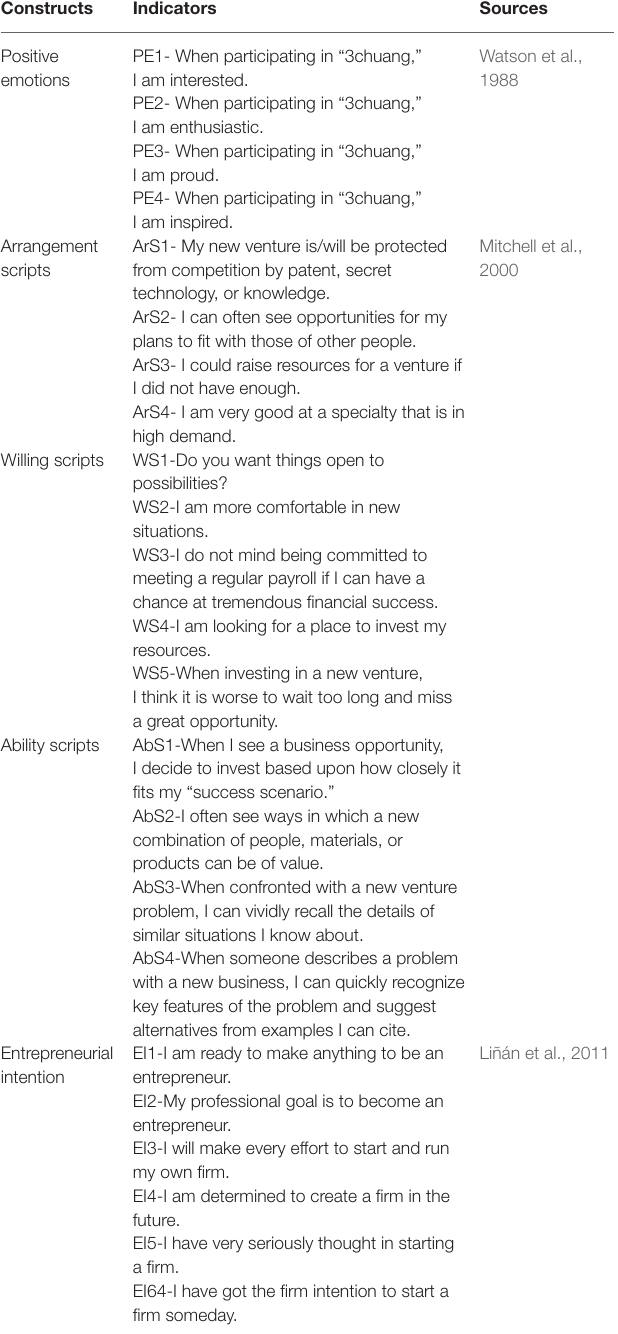
TABLE 1 | Demographic profile of respondents. Demographic profile